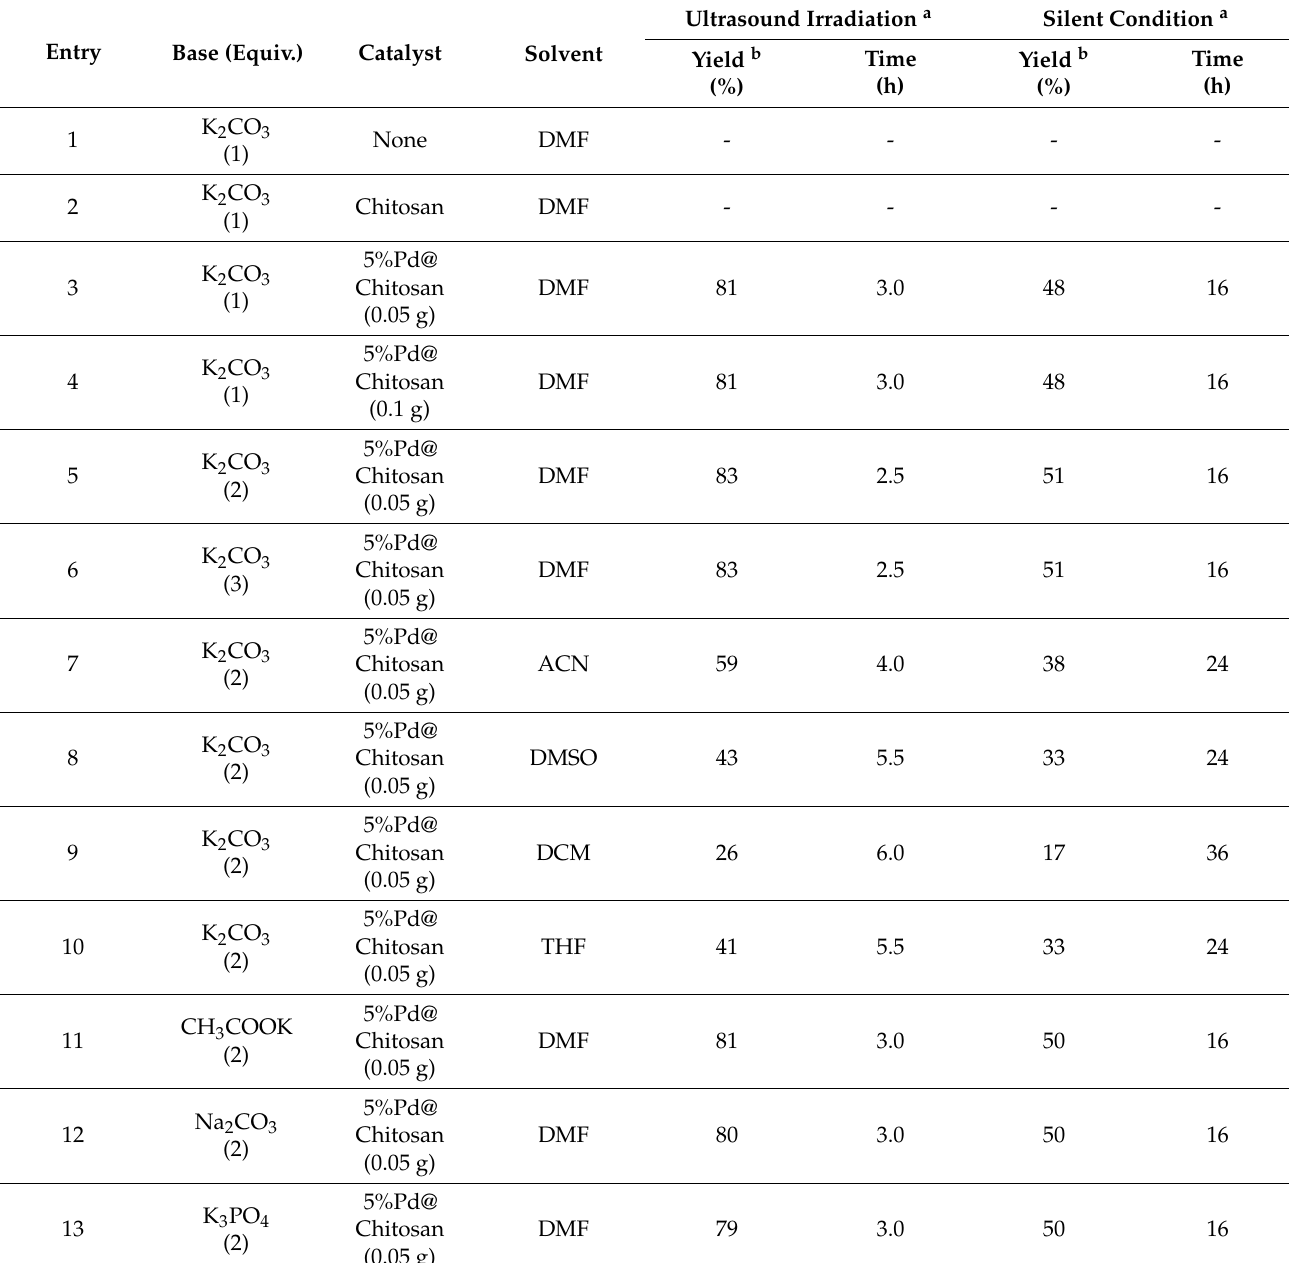
Table 1. The reaction conditions for Pd@Chitosan catalysis of the C-H arylation of